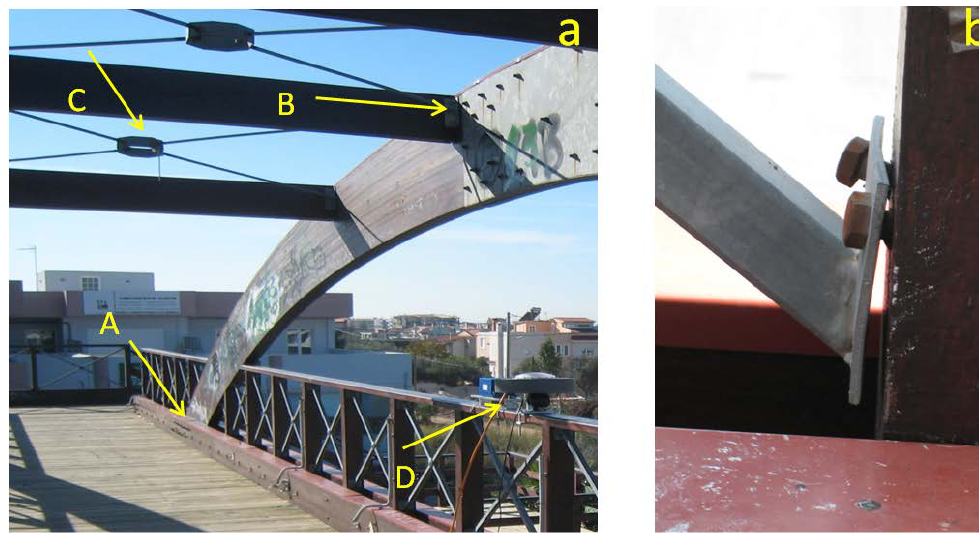
Figure 5. ( a ) Photo of the bridge during the 2007 survey, before damage was observed. Arrow (A) points to connections (2) in Figure 4, in which no signs of splitting are visible. Arrow (B) points to transversal roof beams, which appeared strongly coupled with the two arches. Arrow (C) points to metallic elements, unable to offer rigidity and which were sheared after 2009. Arrow (D) points to some of the collocated sensors (accelerometer, GPS, RTS reflector) used during the annual monitoring surveys; ( b ) A characteristic example of ice-extruded bolt; from a photo taken in 2009.